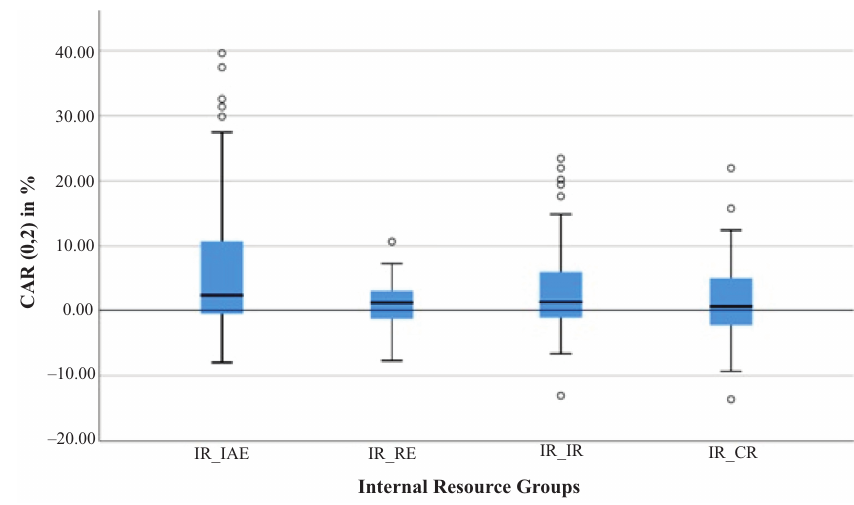
Table 5. Event study results for internal resources sub-groups